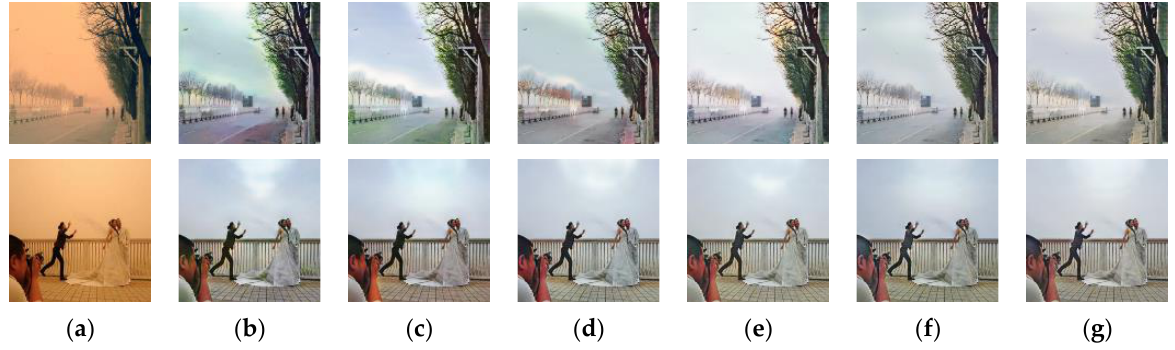
Figure 5. Subjective effects of different components on image quality; ( a ) Sand-dust images; ( b ) Baseline; ( c ) Baseline+a; ( d ) Baseline+b; ( e ) Baseline+a+b; ( f ) Baseline+a+b+adv; ( g ) Base- line+a+b+adv+ploss.